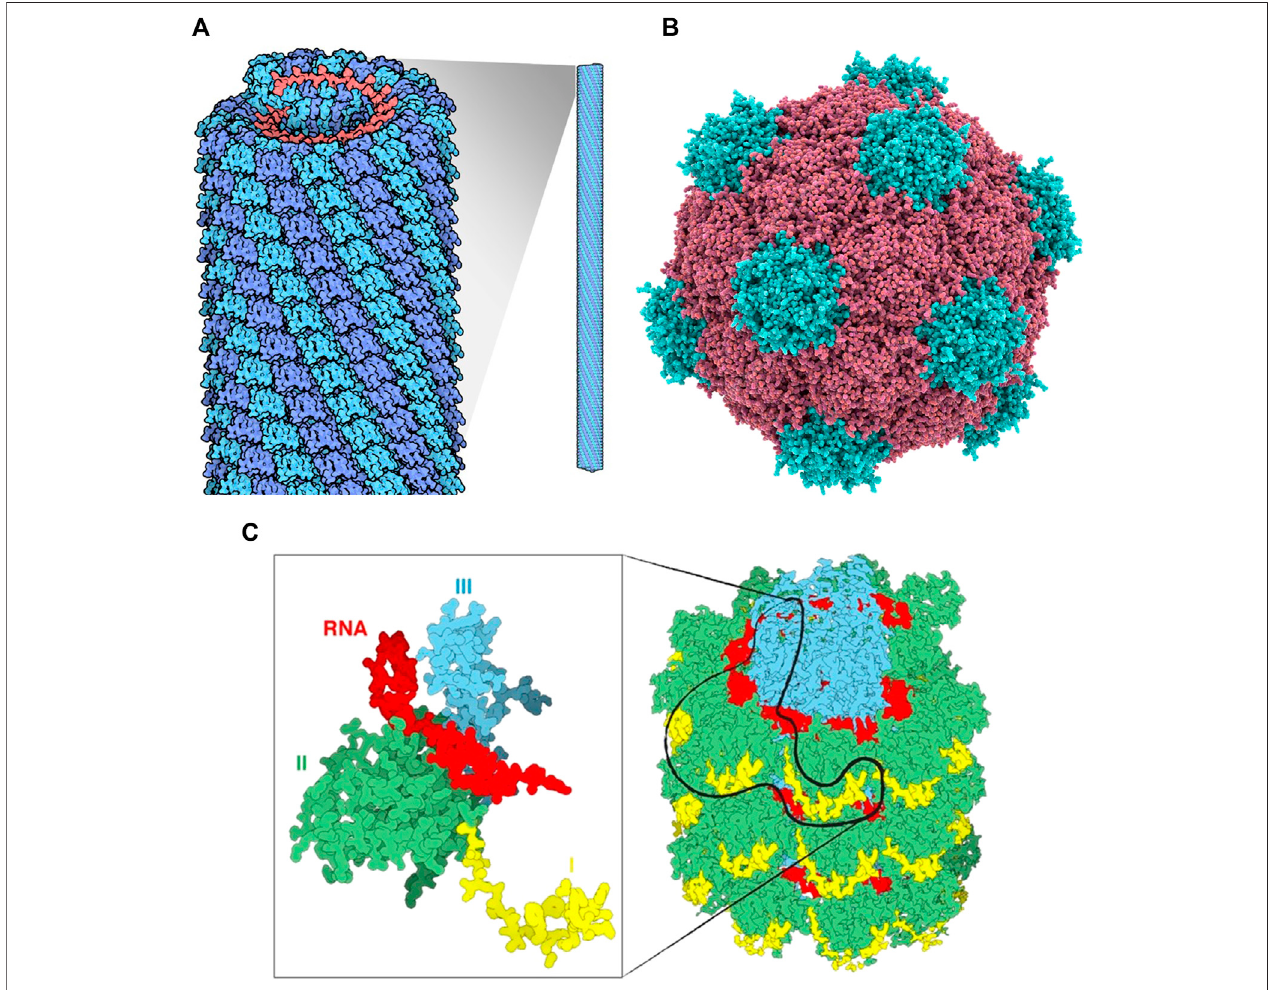
FIGURE 1 | (A) Tobacco mosaic virus structure, RNA is in red, protein subunits in blue Source: https://pdb101.rcsb.org/motm/109. (B) Cowpea mosaic virus structure, Protein subunits inred and blue Source: fi neartamerica. com. (C) An overview ofaportion ofthe PVXvirus (right) . Thethree domains ofthe protein are shin in yellow, green and cyan, the RNA in red. The magni fi cation on the left displays only one single CP with a fragment of